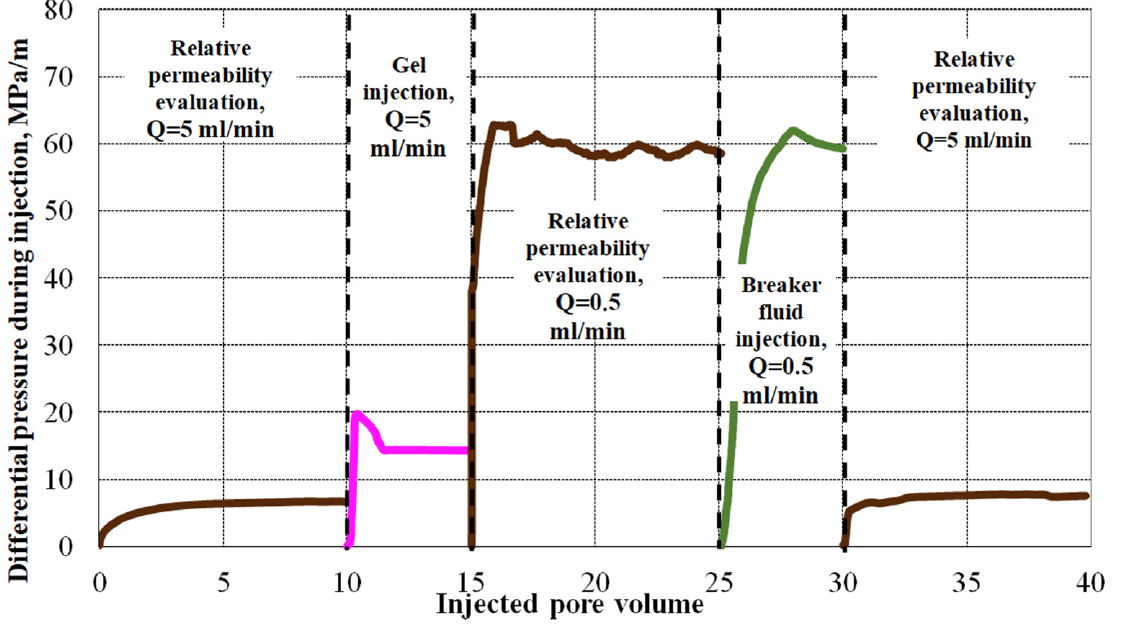
Figure 7. Correlation between the differential pressure and the injected pore volume at oil-saturated fractured porous core sample. Table 3. Results of the flooding experiment on oil-saturated fractured porous core sample.